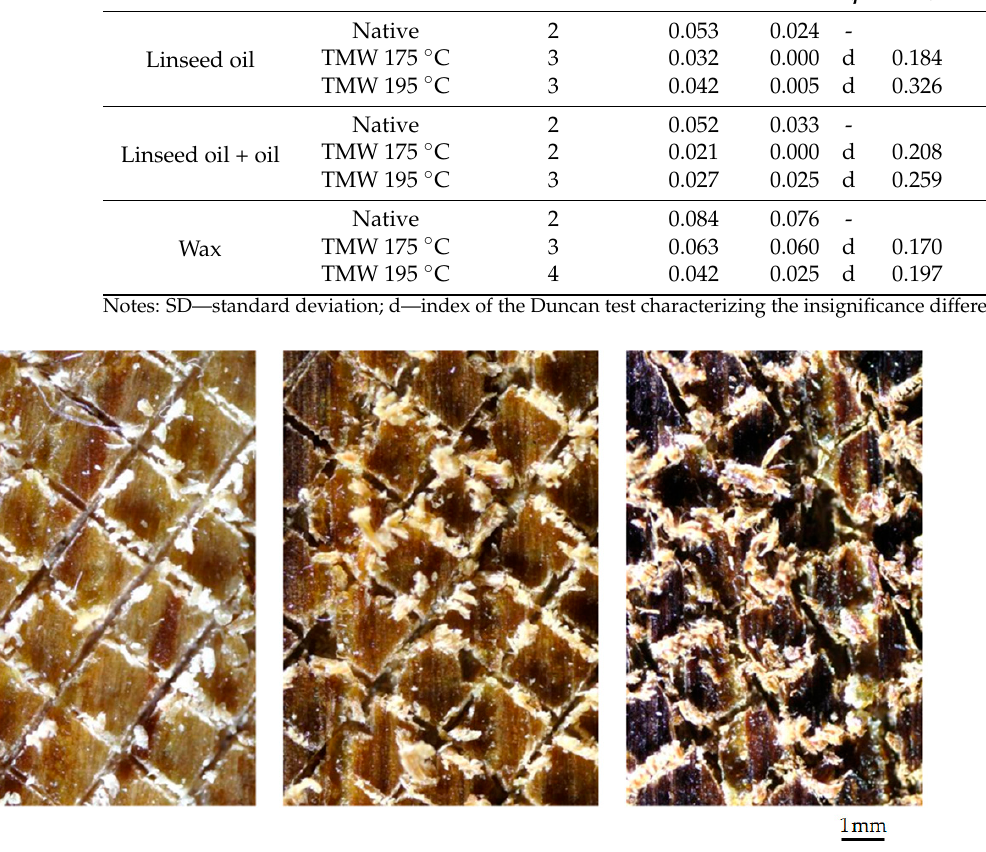
Table 9. Impact resistance of the surface finish: degree and evaluation .